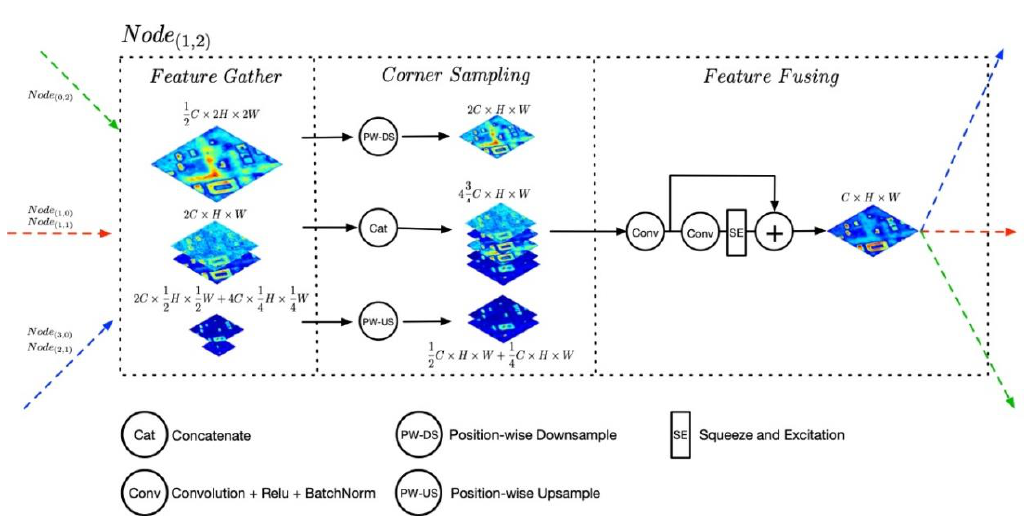
Figure 2. The workflow of Node Layer for Node ( 1,2 ) . C,H,W represent channel numbers, heights, and widths, respectively, of the feature maps in level 1. For clear visualization, the intermediate feature maps coming from intra-level and inter-level node layers are summarized with the dimension